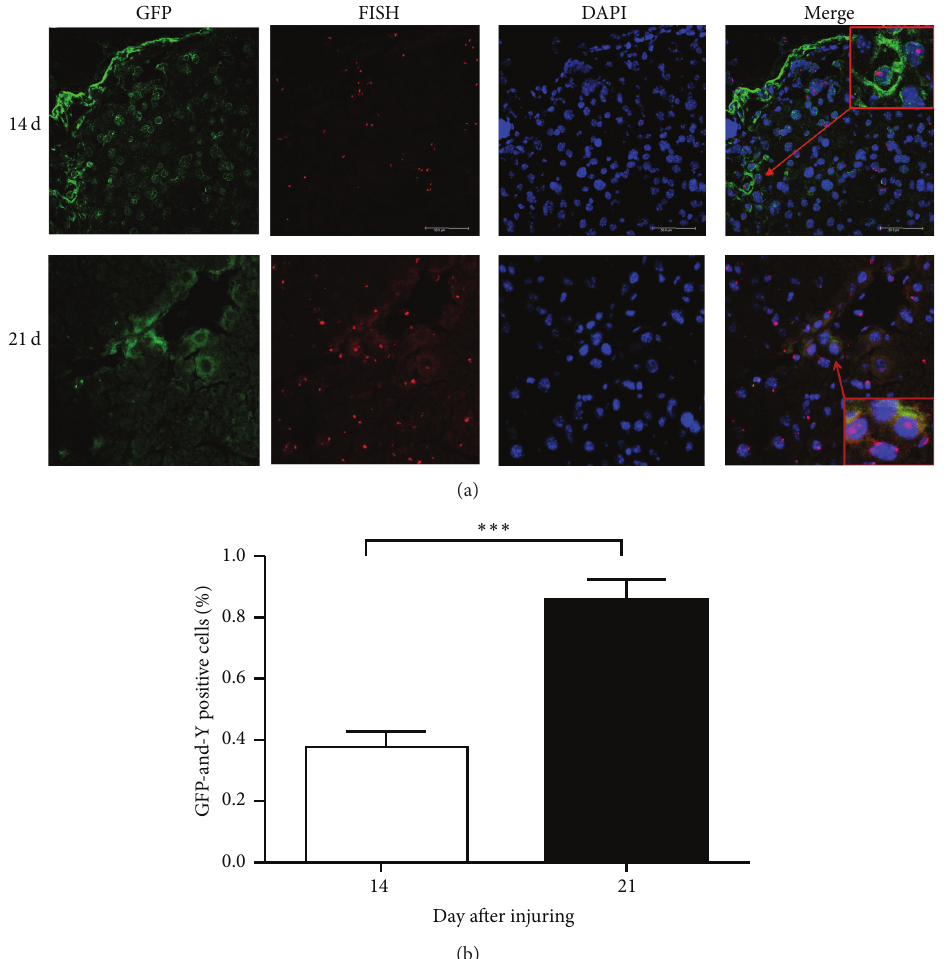
Figure 2: MSCs recruited to injured tissue and fused with hepatocytes. (a) The liver specimens were collected on days 14 and 21 after injury. FISH was used to detect Y-chromosome-positive cells, and IF was used to detect GFP-positive cells. The nuclei were stained blue (DAPI). The images were then merged. Bar: 75 𝜇 m. Arrow was directed to the double positive cells. All the experiments were repeated three times, at least 3 samples were included in each group. (b) Quantitative data of the GFP and Y-chromosome-positive cells in IHC of different days after injuring ( ∗∗∗ 𝑃 < 0.001